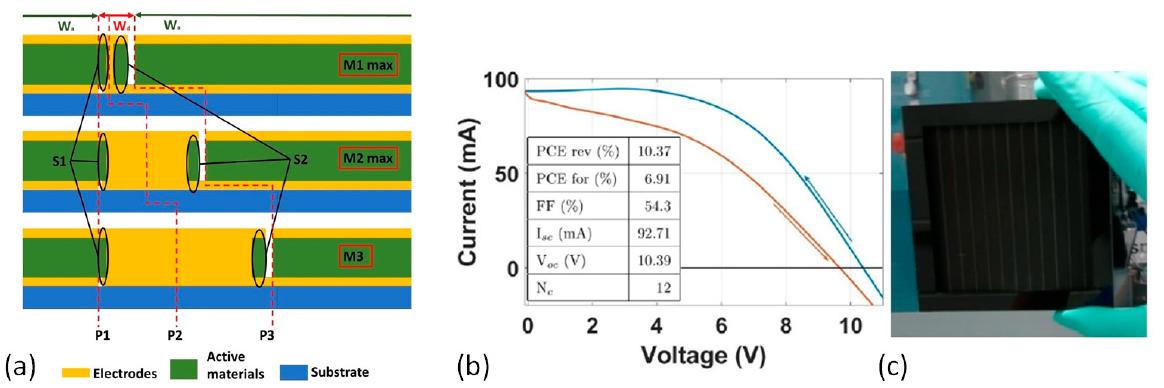
Figure 27. ( a ) Schematic representation of the interconnection areas for the three modules M1max, M2max and M3 with different P2 widths and minimized Wd; ( b ) current–voltage characteristic 10 × 10 cm 2 module with M2max design. In the inset is the table describing the device parameters. ( c ) The 10 × 10 cm 2 module with M2max design [90]. (Reproduced from Ref. [90], 10.3390/en13071589, under the terms of the CC BY [4.0] license.)